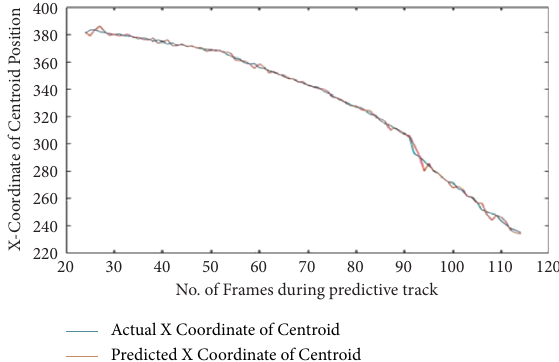
Figure 3: The difference between the predicted X -coordinate and the actual X -coordinate of the vehicles’ centroid during predictive